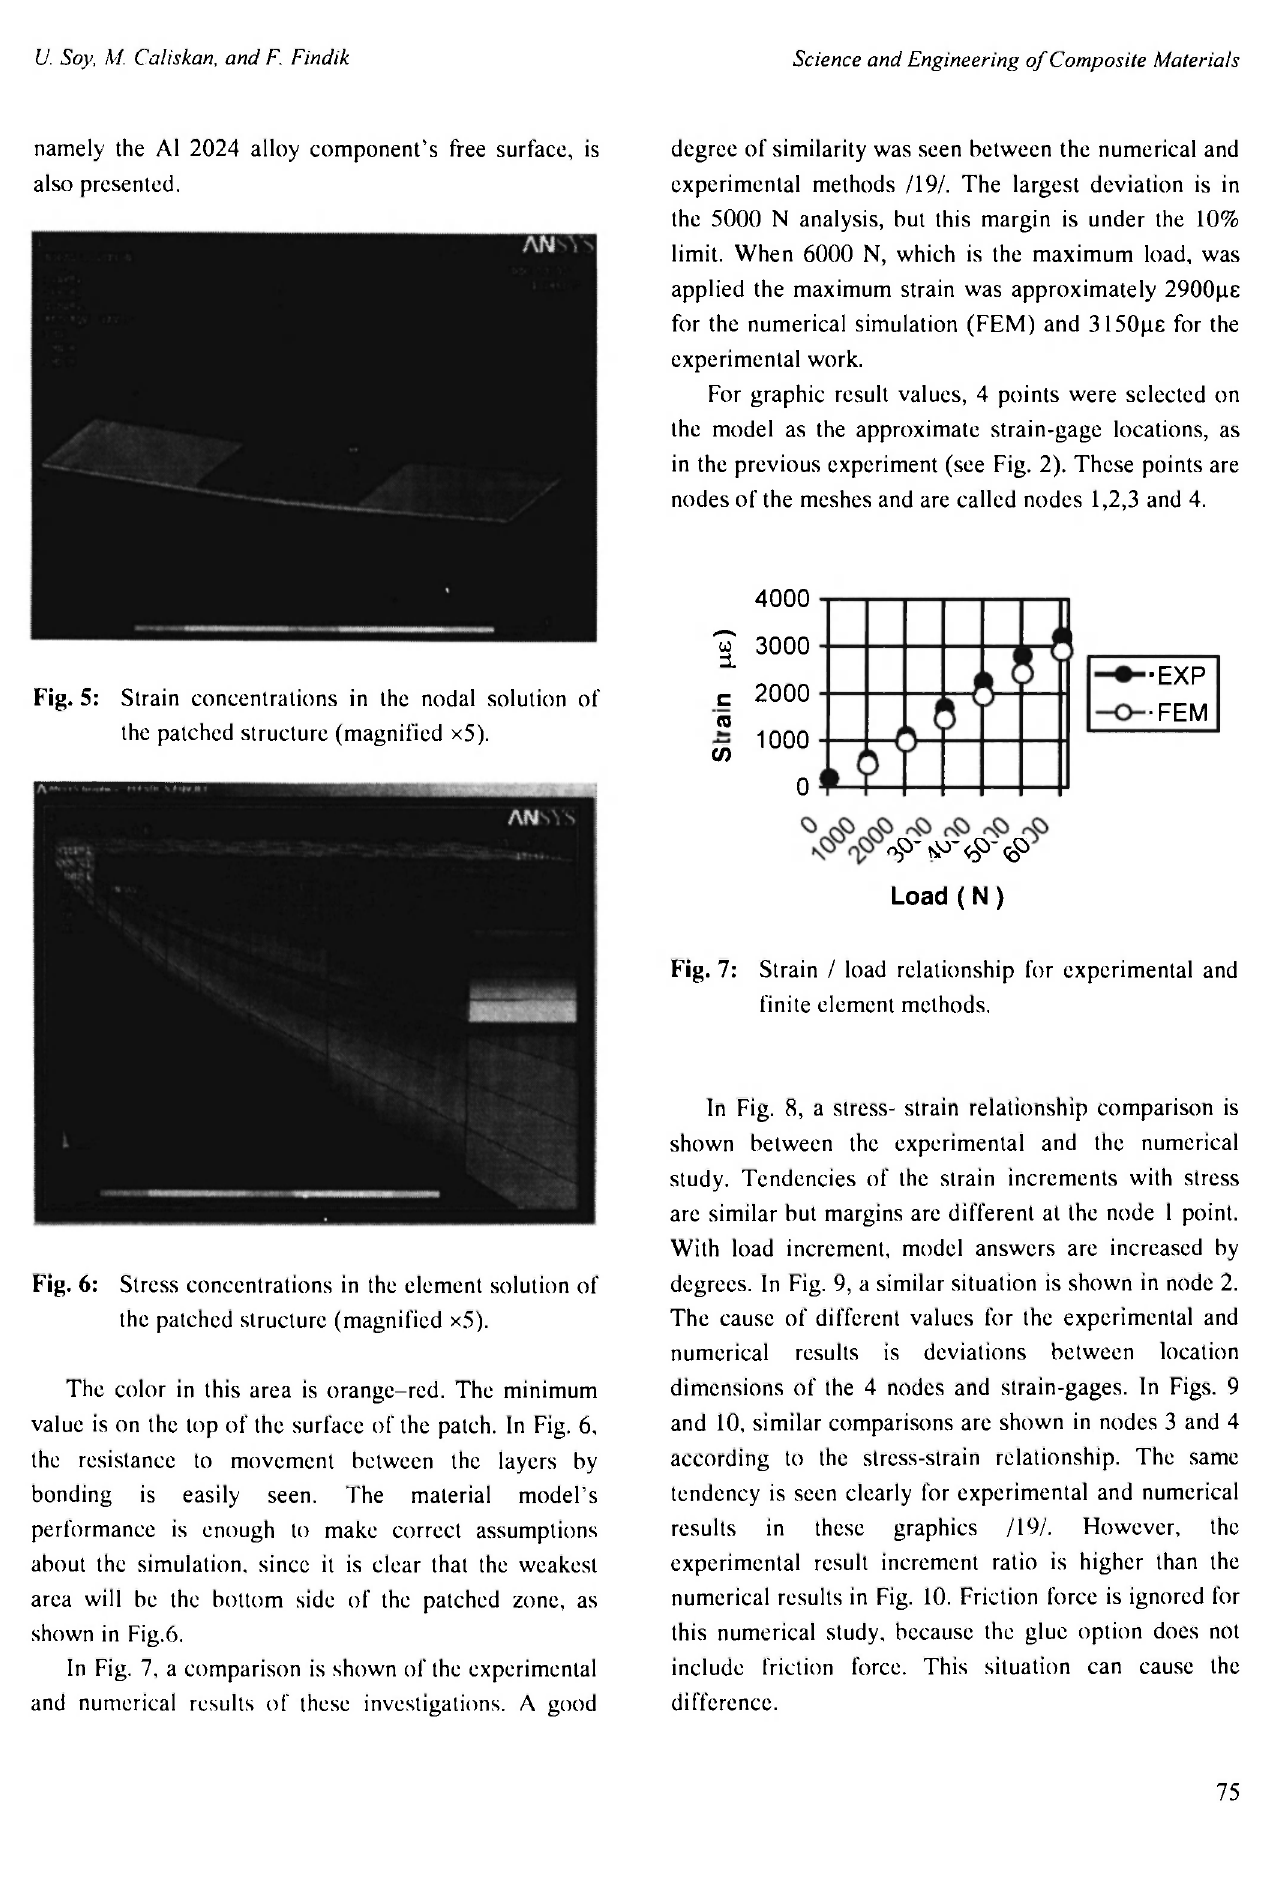
Fig. 5: Strain concentrations in the nodal solution of the patched structure (magnified x5).